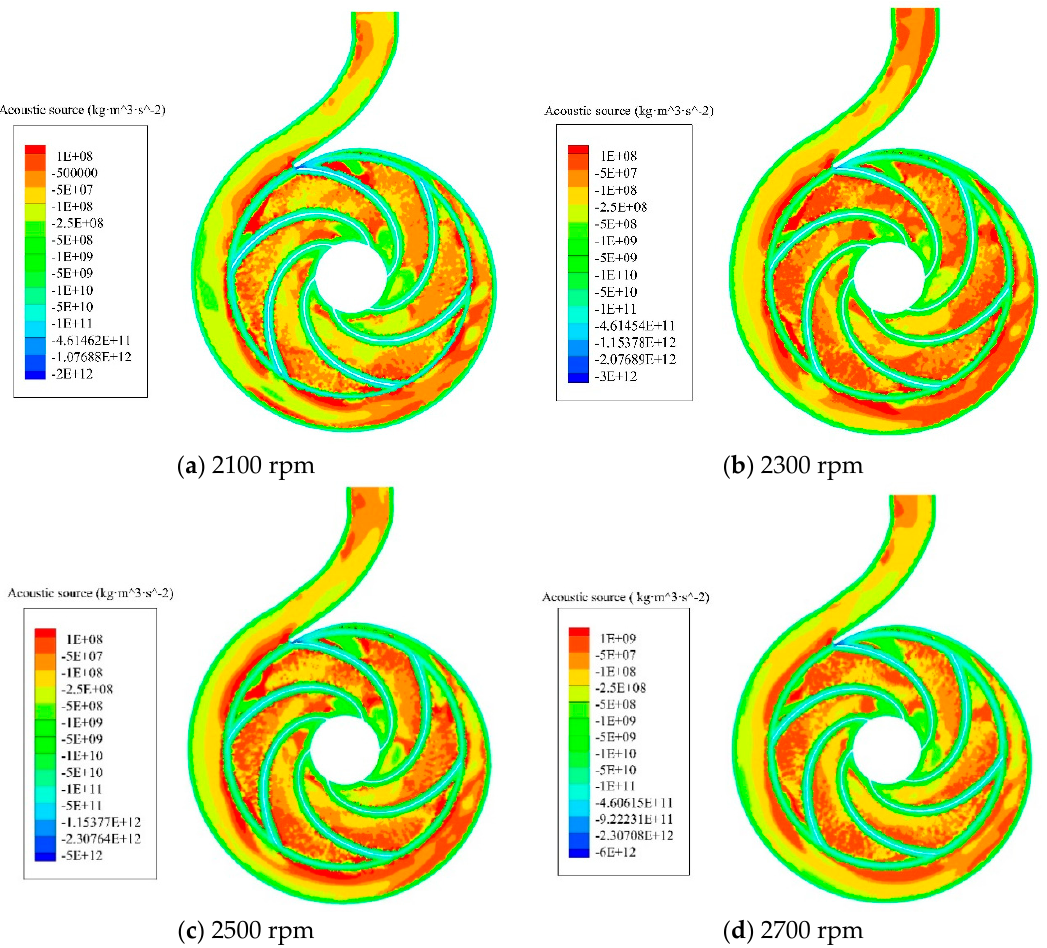
Figure 10. The distribution characteristics of acoustic source under various rotational speeds.